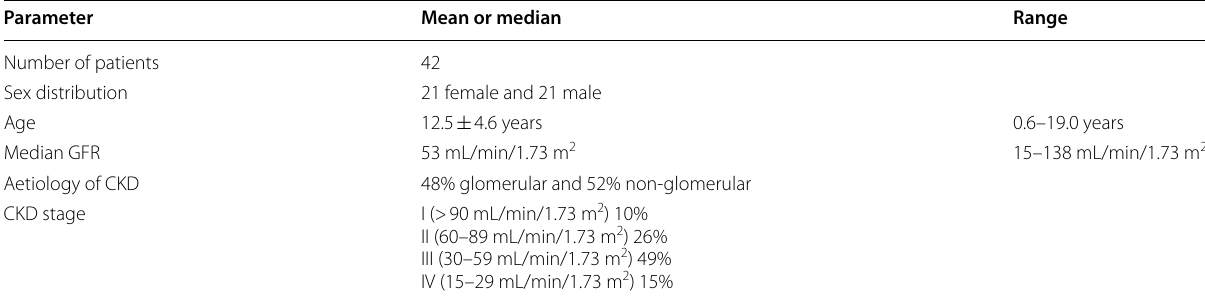
Table 1 Patient characteristics Parameter Mean or median Range Number of